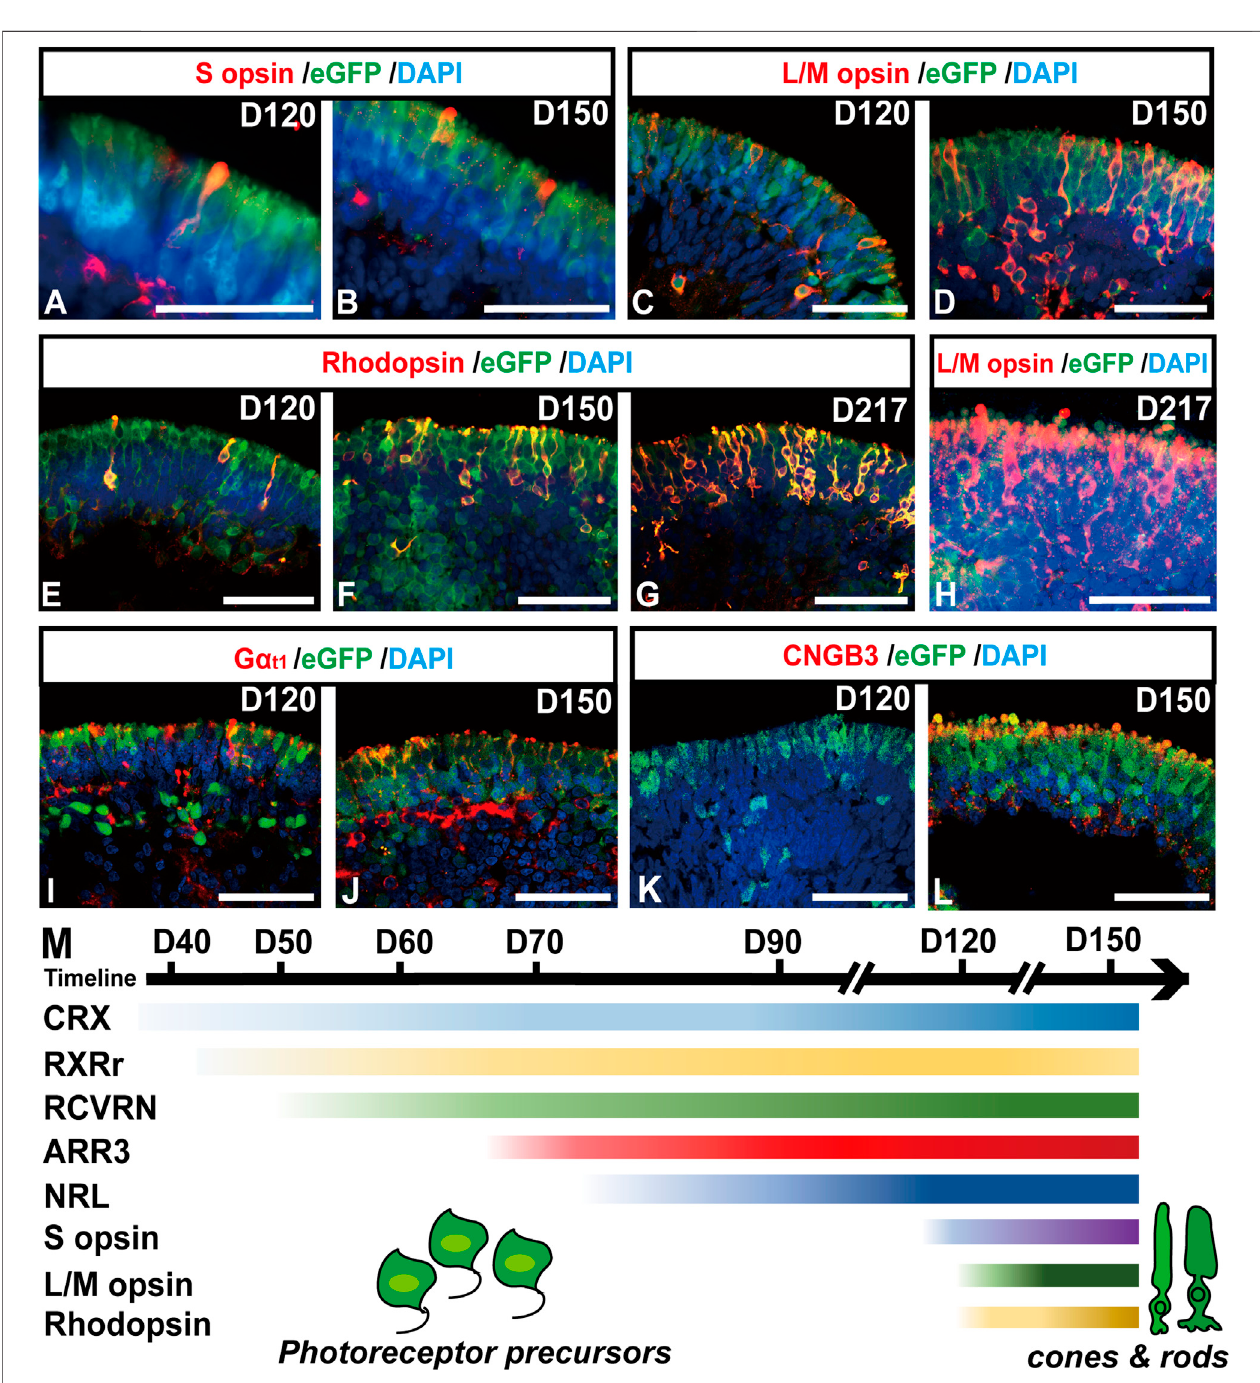
FIGURE 4 | RCVRN-eGFP labels both mature cones and rods in late-stage retinal organoids. (A – L) Immuno fl uorescence images showed the expression of blue conemarkerSopsin,red/greenconemarkerL/Mopsin,rodmarkerRhodopsin, α -subunitofrodtransducin(G α t1 ),andcone-speci fi cphototransductionproteinCNGB3 in eGFP+ cells in late-stage retinal organoids older than D120. (M) Scheme outlined the temporal expression patterns of photoreceptor-speci fi c markers during retinal differentiation in retinal organoids. Nuclei were stained with DAPI. Scale bars, 50 μ m (A – L).